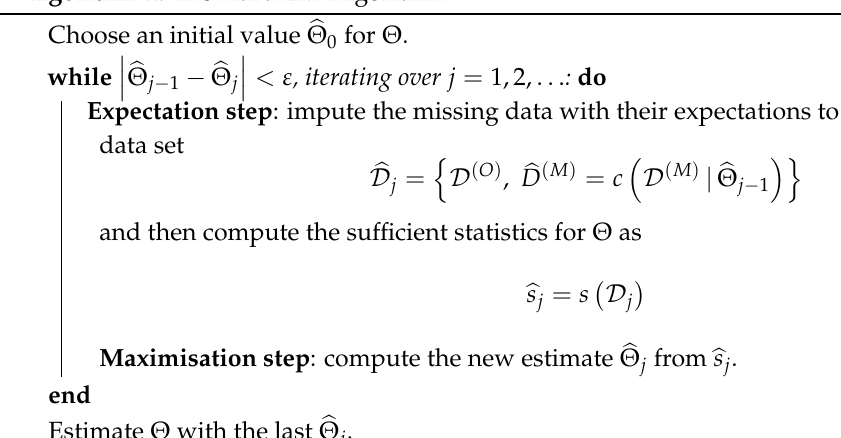
Algorithm 2: The Hard EM Algorithm. Choose an initial value (cid:98) Θ 0 for Θ